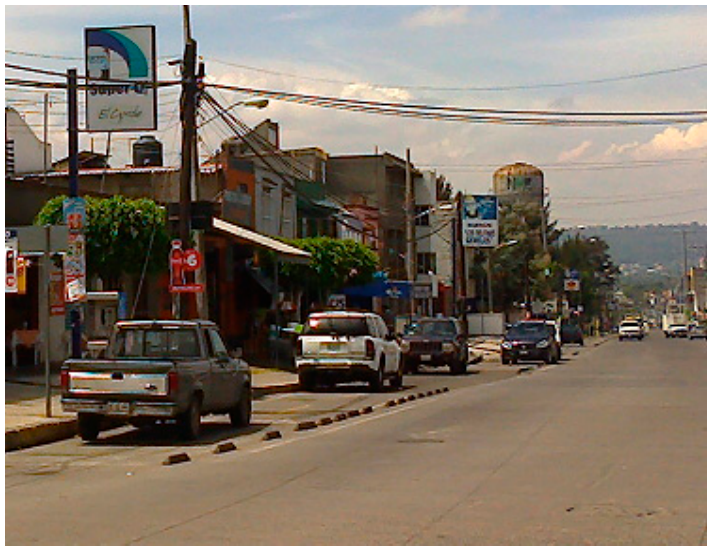
Figure 3. This image was not included in the survey. It shows how drivers park on a cycle track built in the city of Morelia around 2013.